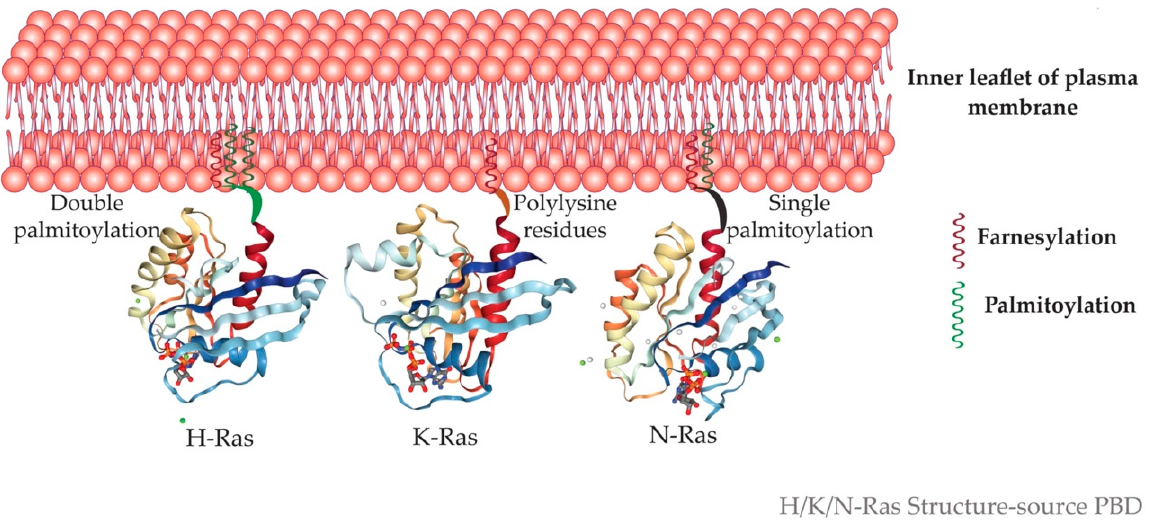
Figure 3. Ras isoforms are attached to the inner leaflet of the plasma membrane. Palmitoylation of residues 181 and 184 in H-Ras and residue 181 in N-Ras makes it hydrophobic and enables membrane attachment. The process of palmitoylation is reversible and depalmitoylated H/N-Ras rapidly shuttles between Golgi and Plasma membrane. Polylysine residues in K-Ras give it hydrophobicity and tether it to the plasma membrane. (PDB structures: H-Ras [73]; K-Ras [74]; N-Ras [75]; NGL (WebGL) viewer [76]. The membrane attachment structure is purely for visualization purposes only.